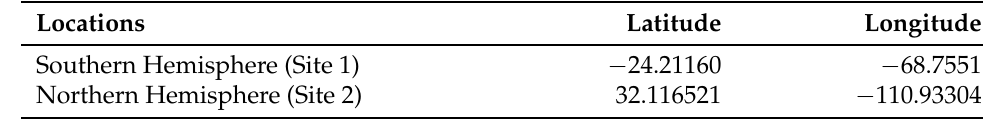
Table 5. Locations selected for the case studies.